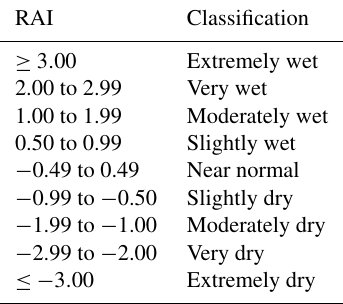
Table 3. Classification of the period according to the values of the RAI.